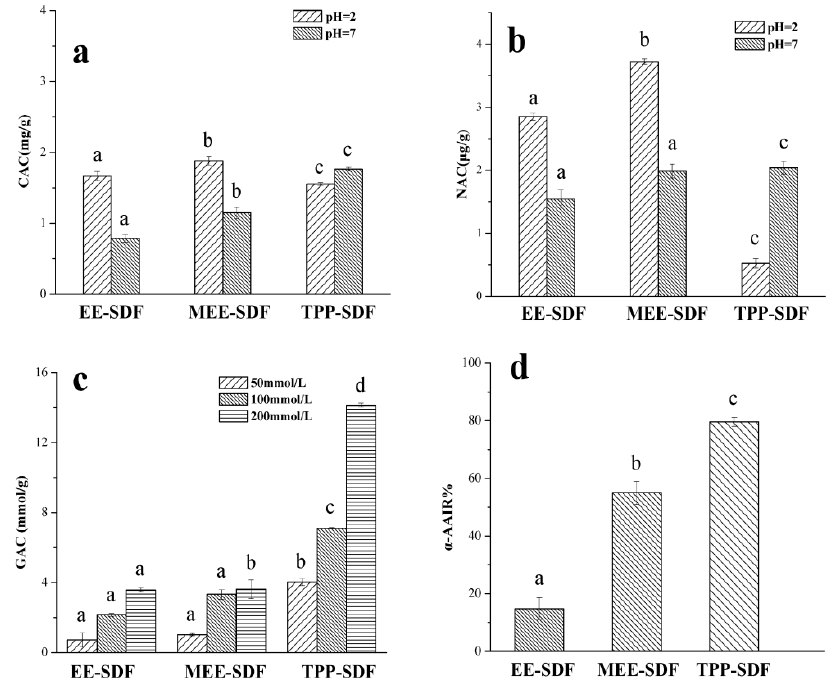
Figure 4. Hypoglycemic activity of SDFs obtained with different extraction methods. CAC ( a ), NAC ( b ), GAC ( c ), and α -AAIR ( d ). Different letters are statistically different ( p < 0.05).